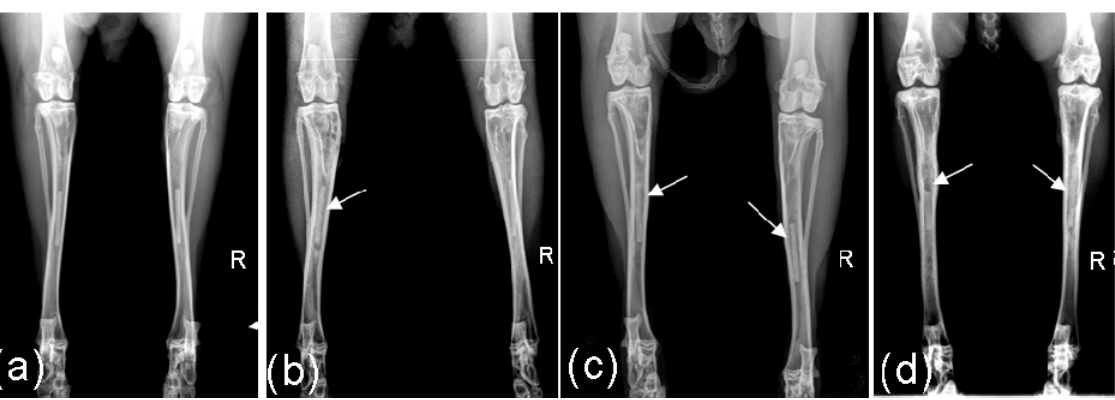
Figure 1. Radiological images of implants: ( a ) after 4 weeks implantation period: Score left 0, right 0; ( b ) after 8 weeks implantation period: Score left 1, right 0; ( c ) after 13 weeks implantation period: Score left 1, right 1; ( d ) after 26 weeks: Score 3 and low level of gas formation left, score 2